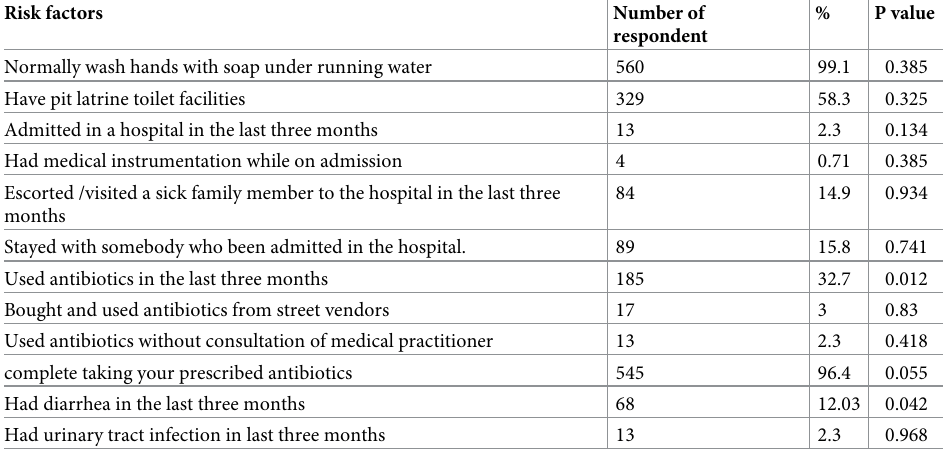
Table 7. Risk factors for faecal carriage of ESBL producing Enterobacteriaceae among food handlers in West Coast Region. Risk